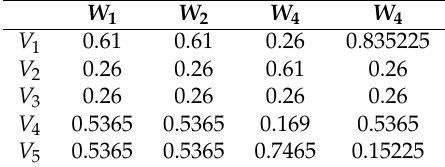
Table 4. The objective function weights with the degree of disaster